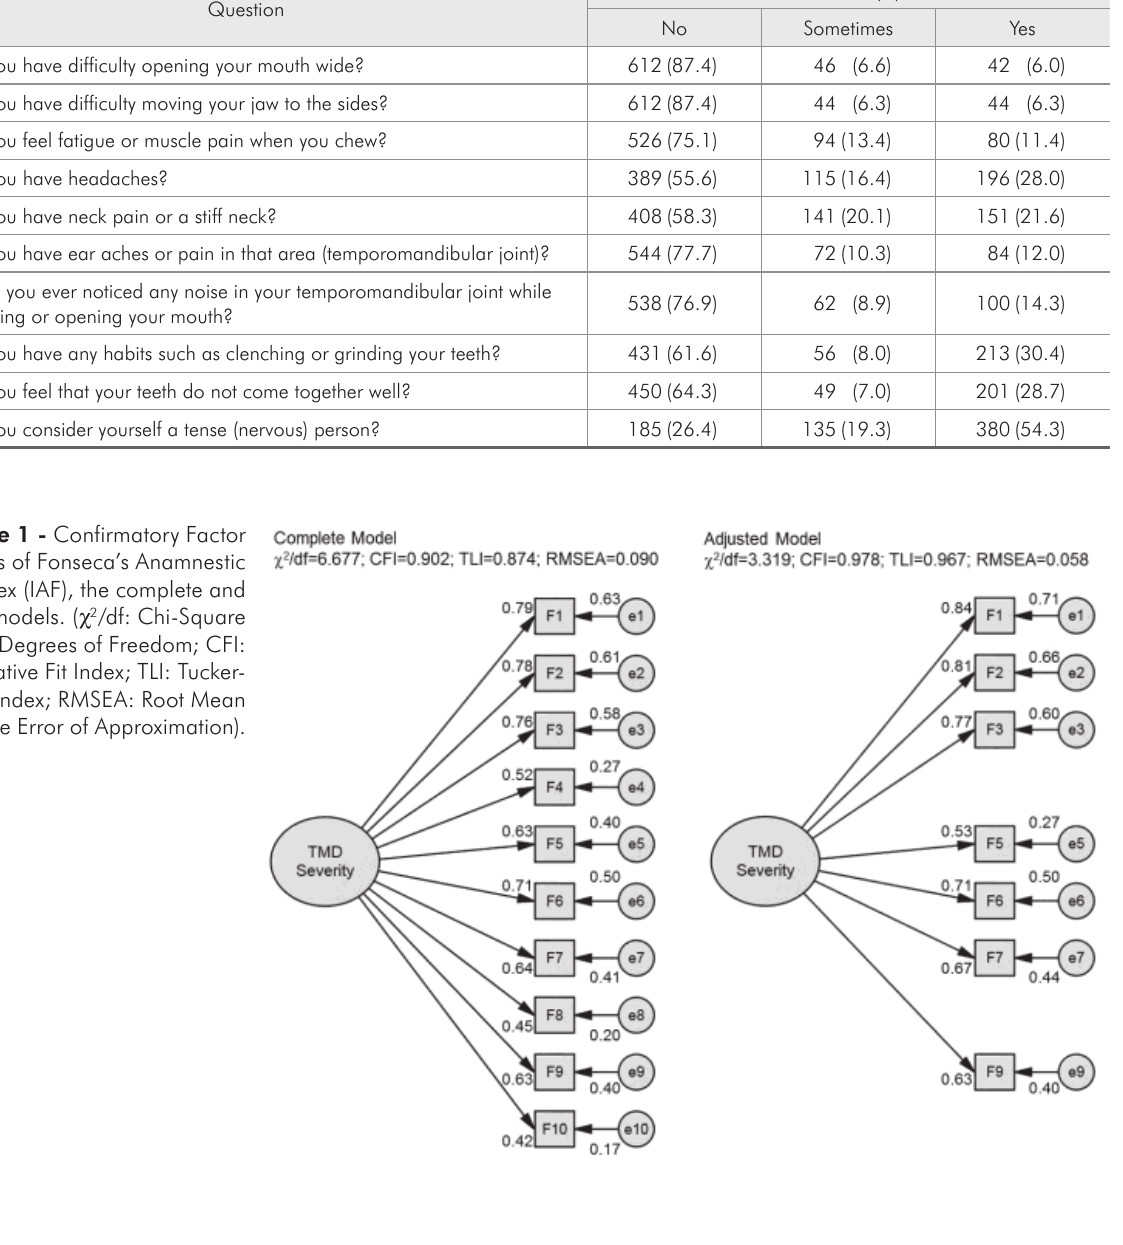
Table 1 - Distribution of participants according to the responses to each question of Fonseca’s Anamnestic Index (IAF). Question